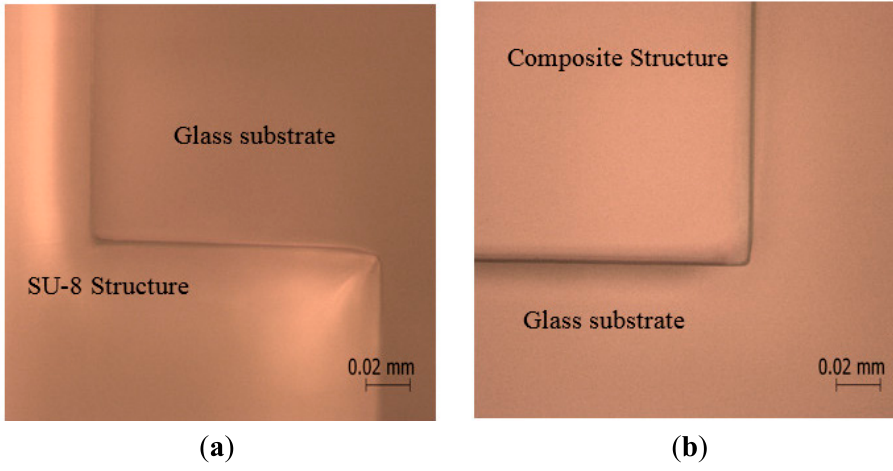
Figure 4. Optical micrograph of UV-patterned microstructures on ( a ) pristine SU-8 and ( b ) composite with 4 wt % ionic